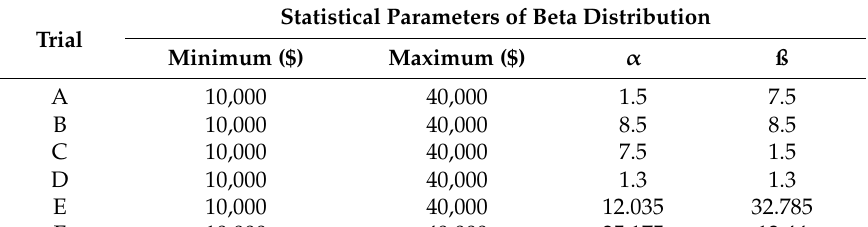
Table 13. Results of sensitivity analysis of mapping values.